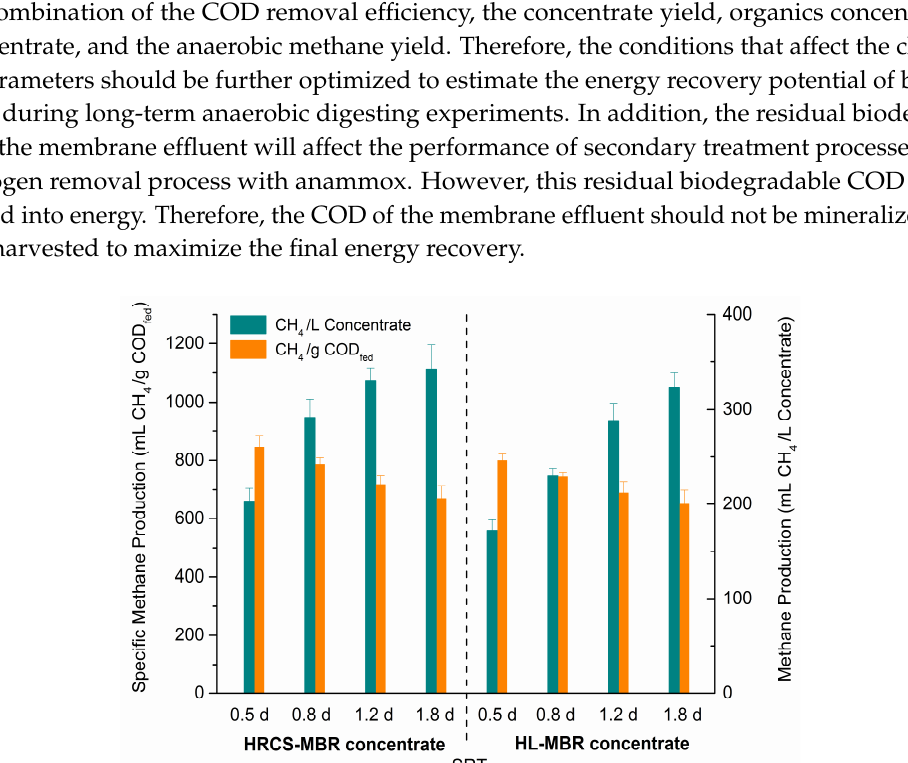
Figure 7. Evolutions of permeability as a function of permeate volume in two MBRs at different SRTs. Conversely, colloids and SMP were reported to also be primary membrane foulants in MBRs [41]. Thus, we examined COD coll and SMP concentrations of concentrate to investigate the correlation